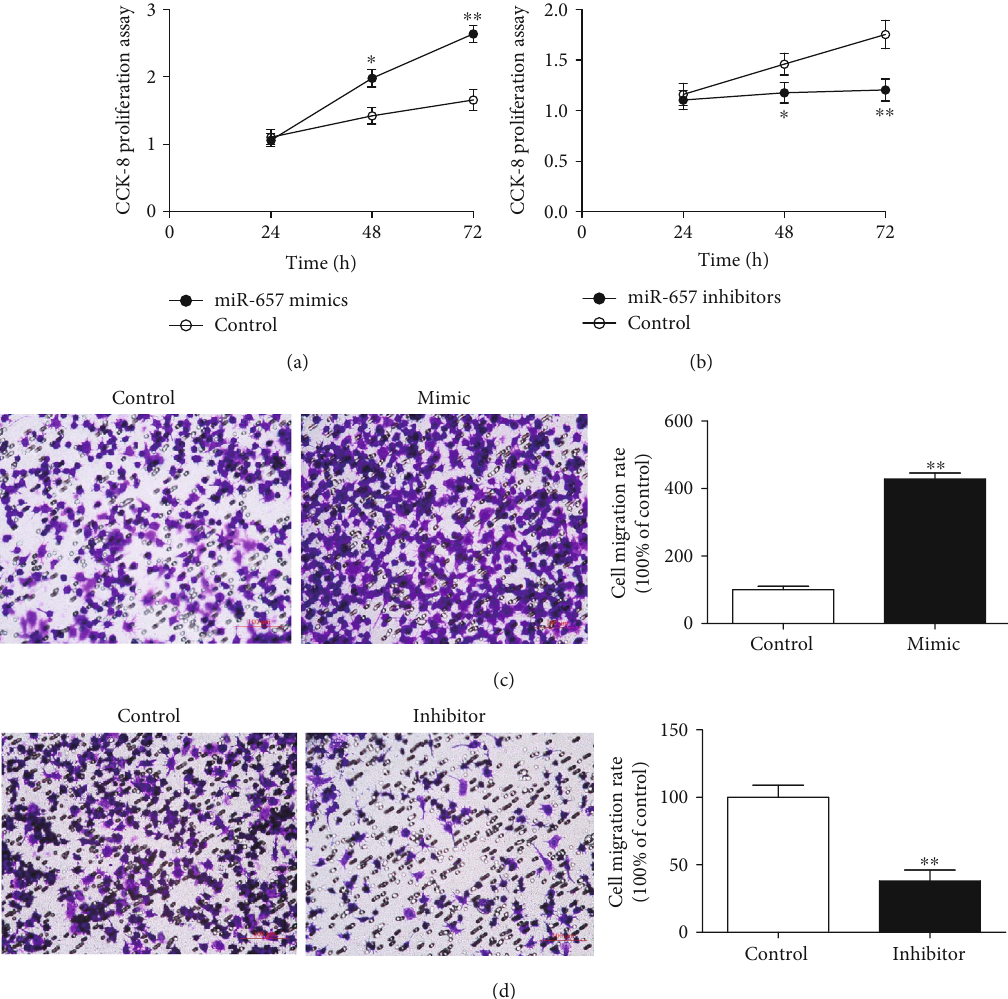
Figure 3: miR-657 regulates macrophage proliferation and migration in vitro. (a) miR-657 mimics increase the proliferation of THP-1 cells in a time-dependent manner ( ∗ P < 0 : 05 ; ∗∗ P < 0 : 01 ; data of three independent analyses). (b) miR-657 inhibitors inhibit THP-1 cell proliferation in a time-dependent manner ( ∗ P < 0 : 05 ; ∗∗ P < 0 : 01 ; three independent tests). (c) miR-657 mimics promote macrophage migration ( ∗∗ P < 0 : 01 ; representative data of three independent tests). (d) miR-657 inhibitors decrease macrophage migration ( ∗∗ P < 0 : 01 ; representative picture of three independent